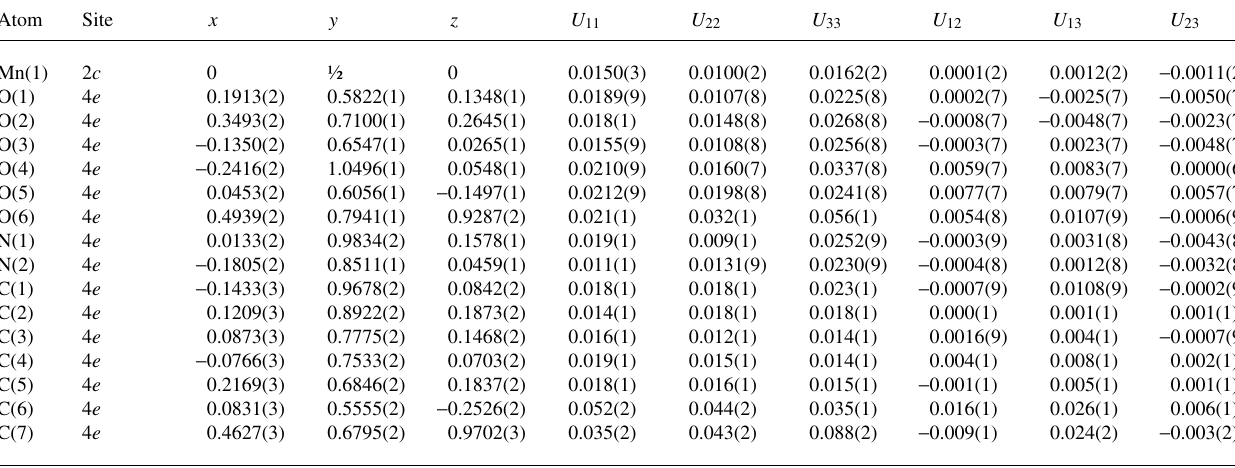
Table 3. Atomic coordinates and displacement parameters (in Å 2 ) .